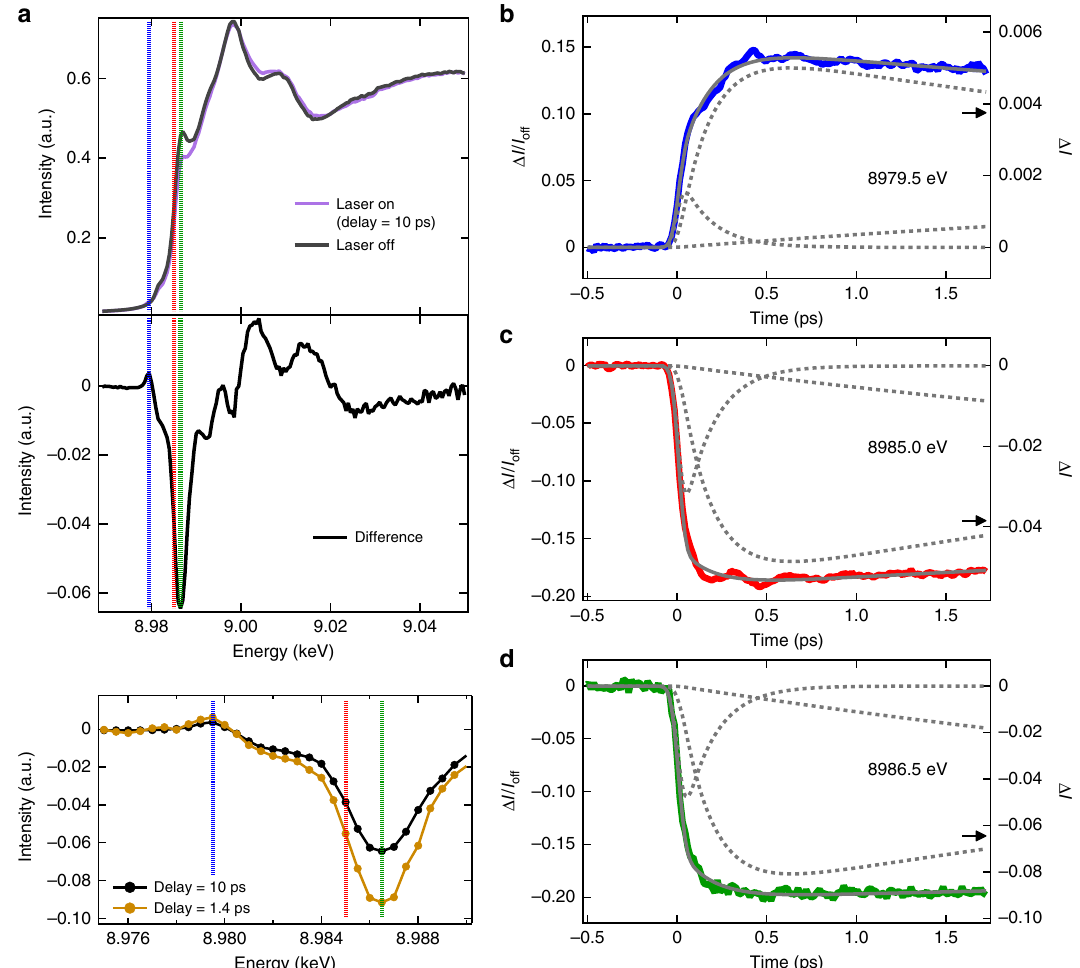
Fig. 2 Femtosecond dynamics of [Cu(dmphen) 2 ] + . a The top presents Cu K-edge XANES spectra of the [Cu(dmphen) 2 ] + ground state (a black line) and the T 1 state (a purple line) measured at 10 ps after optical laser irradiation. The middle shows the difference spectrum between these two spectra. The bottom is a zoomed view of the difference spectra measured at 10 ps and at 1.4 ps. The blue, red, green dotted lines denote an excitation photon energy of 8979.5, 8985.0, and 8986.5 eV, respectively. b – d The femtosecond time dependence of the transient XANES signal measured at b 8979.5eV, c 8985.0 eV, and d 8986.5 eV, respectively. The results of the global fi tting analysis are overlaid as gray solid lines on the experimental data. Each multiexponential function used in the fi tting analysis is shown as gray dot lines. The arrows in b – d correspond to the transient signal intensity at 10 ps shown in the middle and bottom of